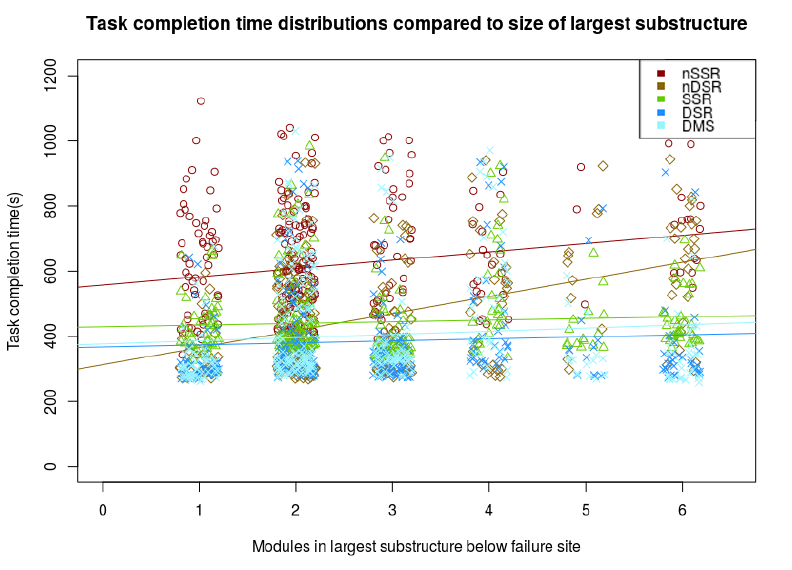
Figure 15. Comparing completion times for the locomotion task, during which the self-repair operation occurred, to the size of the largest single substructure below the failed module shows stronger correlations, 0.18 and 0.4 for nSSR and nDSR, respectively, for naive strategies than for self-repair based strategies. The self-repair strategies plausibly appear uncorrelated to the size of the largest substructure involved in the self-repair operation, suggesting them to be highly